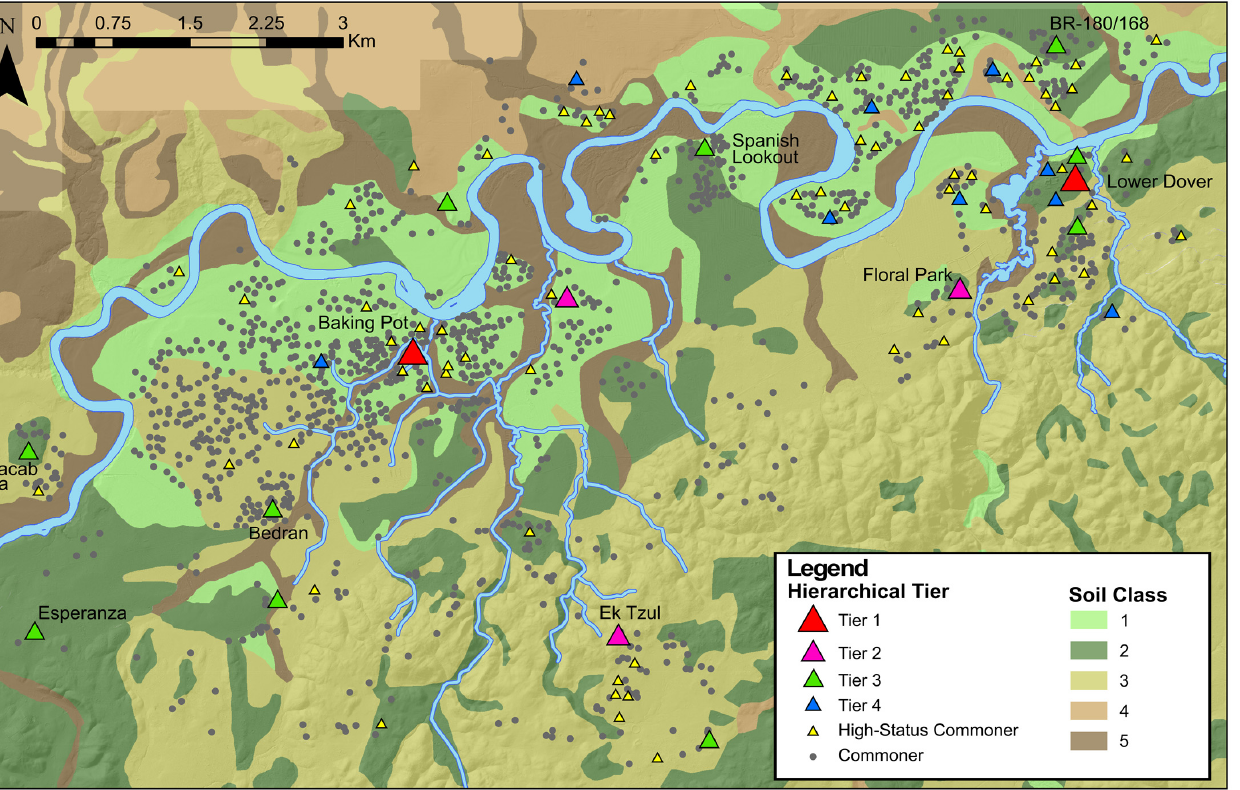
Figure 9. Map of Baking Pot and Lower Dover showing household location relative to soil classifi- cations.